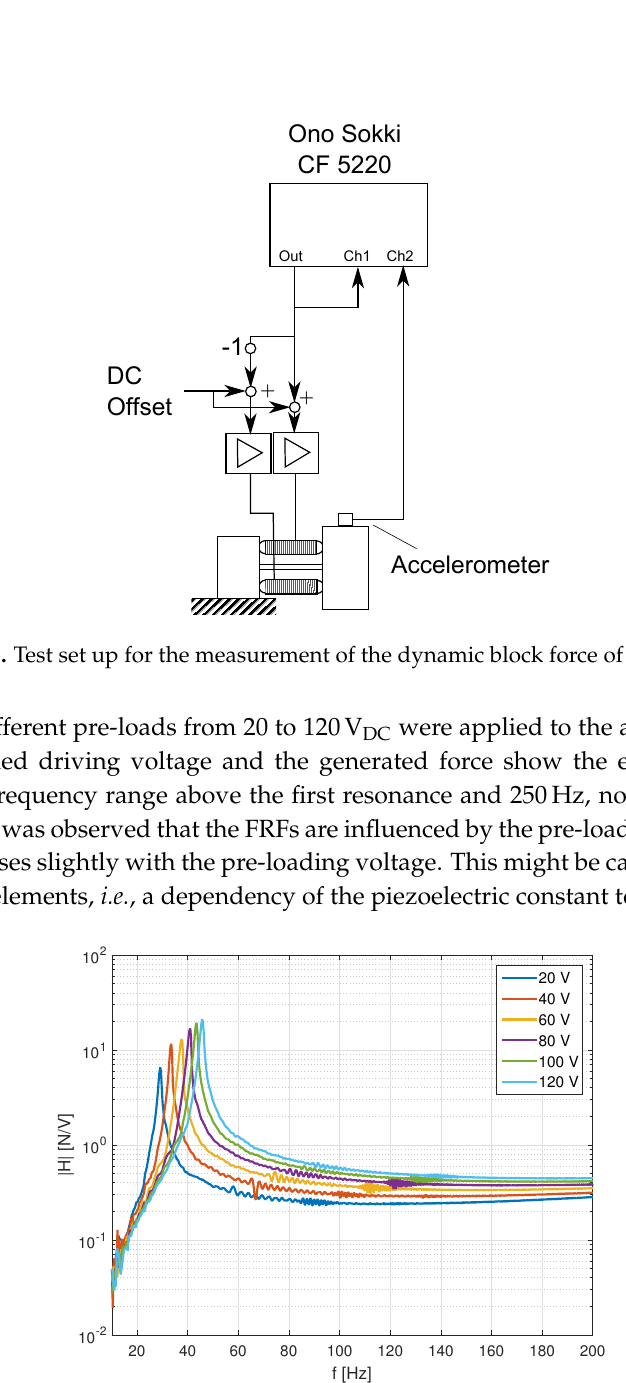
Figure 12. Measurement of the dynamic block force of the